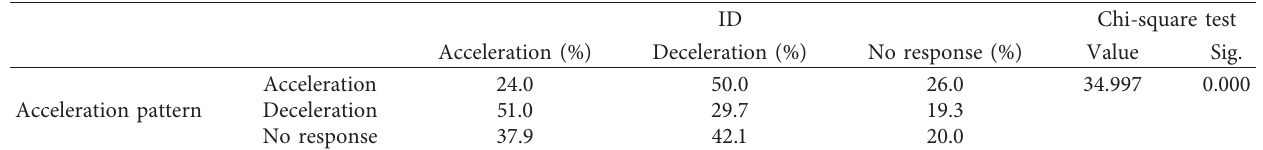
Table 4: Crosstab and Chi-square test result of ID. ID Chi-square